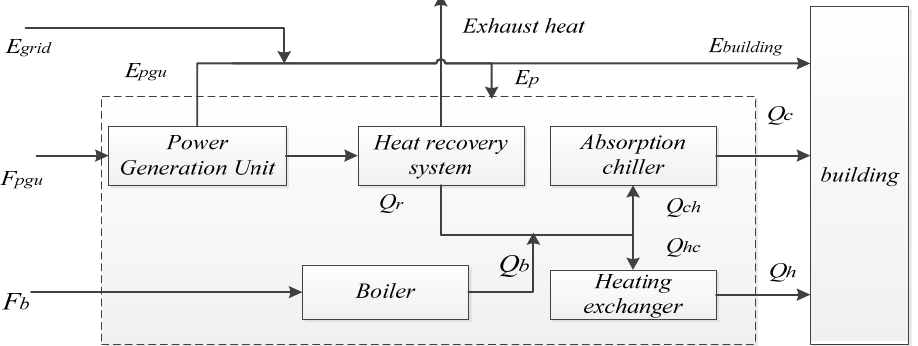
Figure 2. General CCHP system layout for building and energy